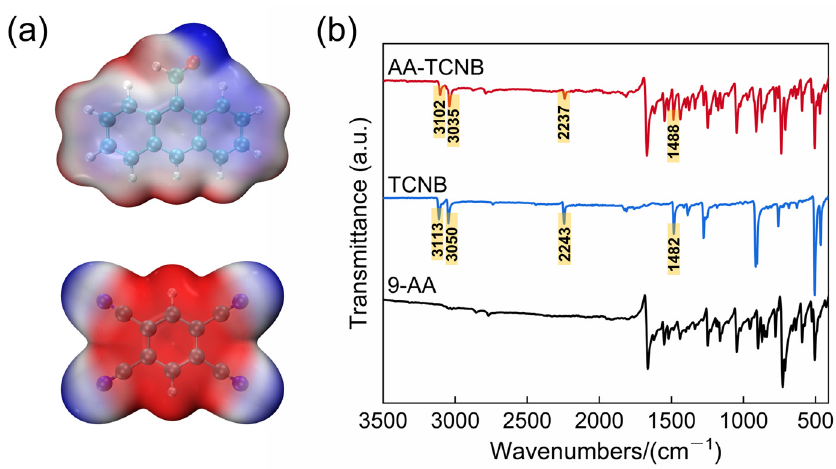
Figure 4. ( a ) Surface electrostatic potentials for 9-AA (top) and TCNB (bo tt om). ( b ) IR spectra of the AA-TCNB and its starting materials. AA-TCNB and its starting